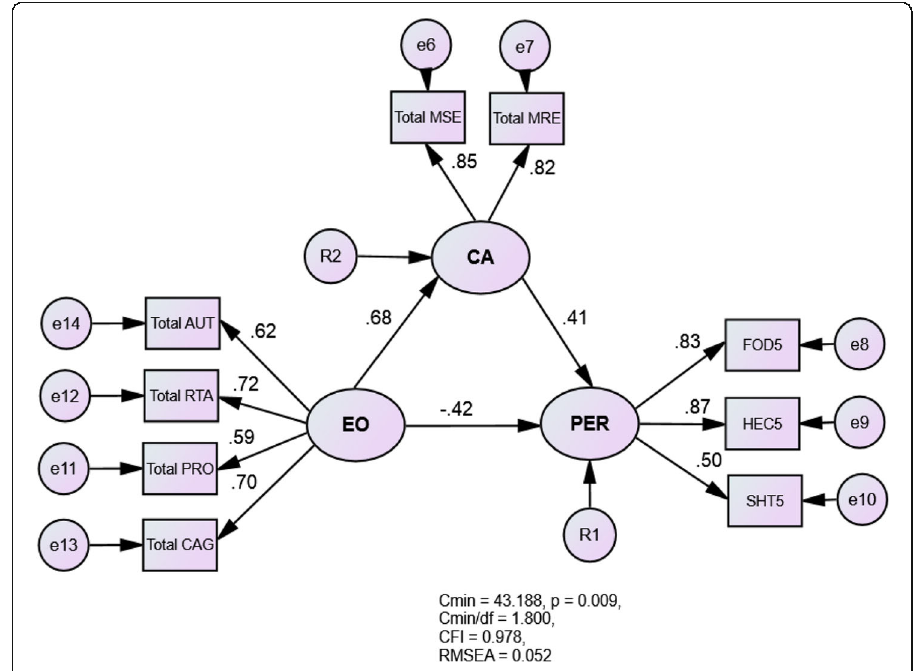
Fig. 4 Structural model for personal wealth measures